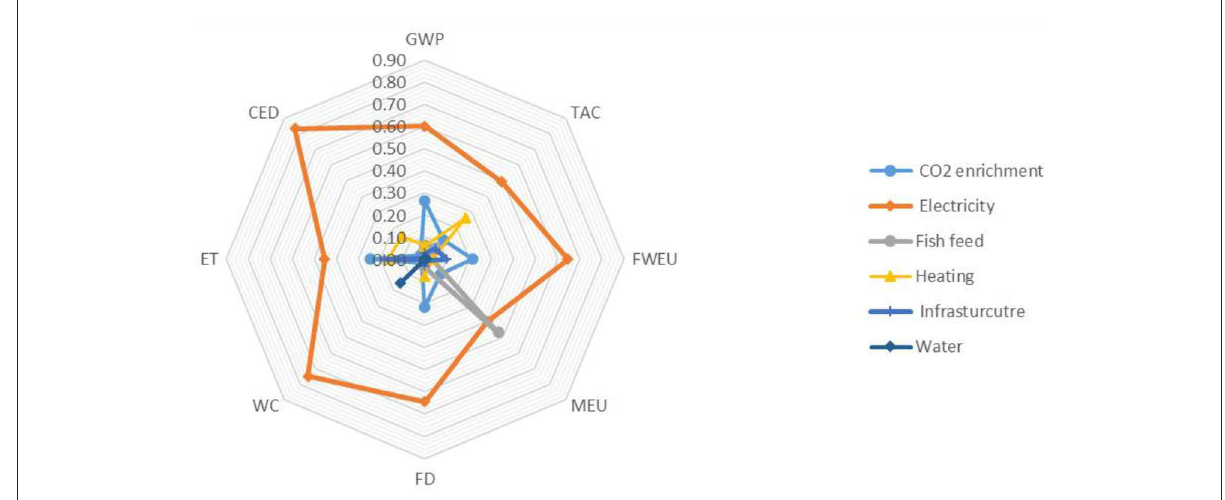
FIGURE3 SFs (axis) for the most influential parameters in each impact category (outer labels). Further details are provided in Supplementary Table A3.